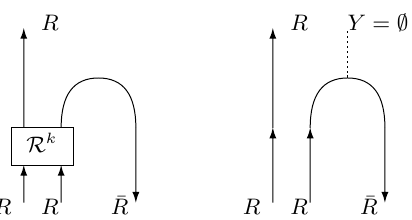
Figure 1 . Speci(cid:12)c trident block the right, the trivial trident block